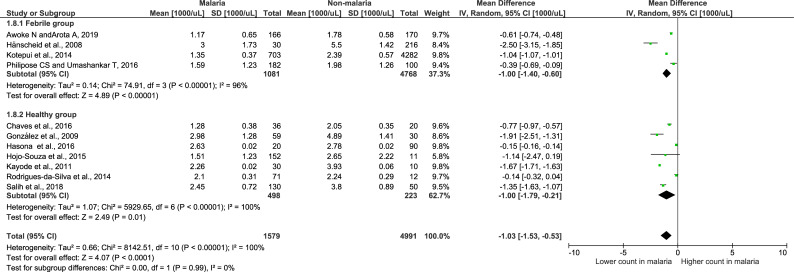
Forest plot of the lymphocyte count among included studies.Forest plot showing the lymphocyte count in the malaria and non-malaria groups. [1000/μL] refers to 1000 per microliter; “IV" in "IV, Random” refers to Inverse variance; "Total" in top row refers to number of patients included; A green square in the horizontal line refers to the mean difference for each of included study.